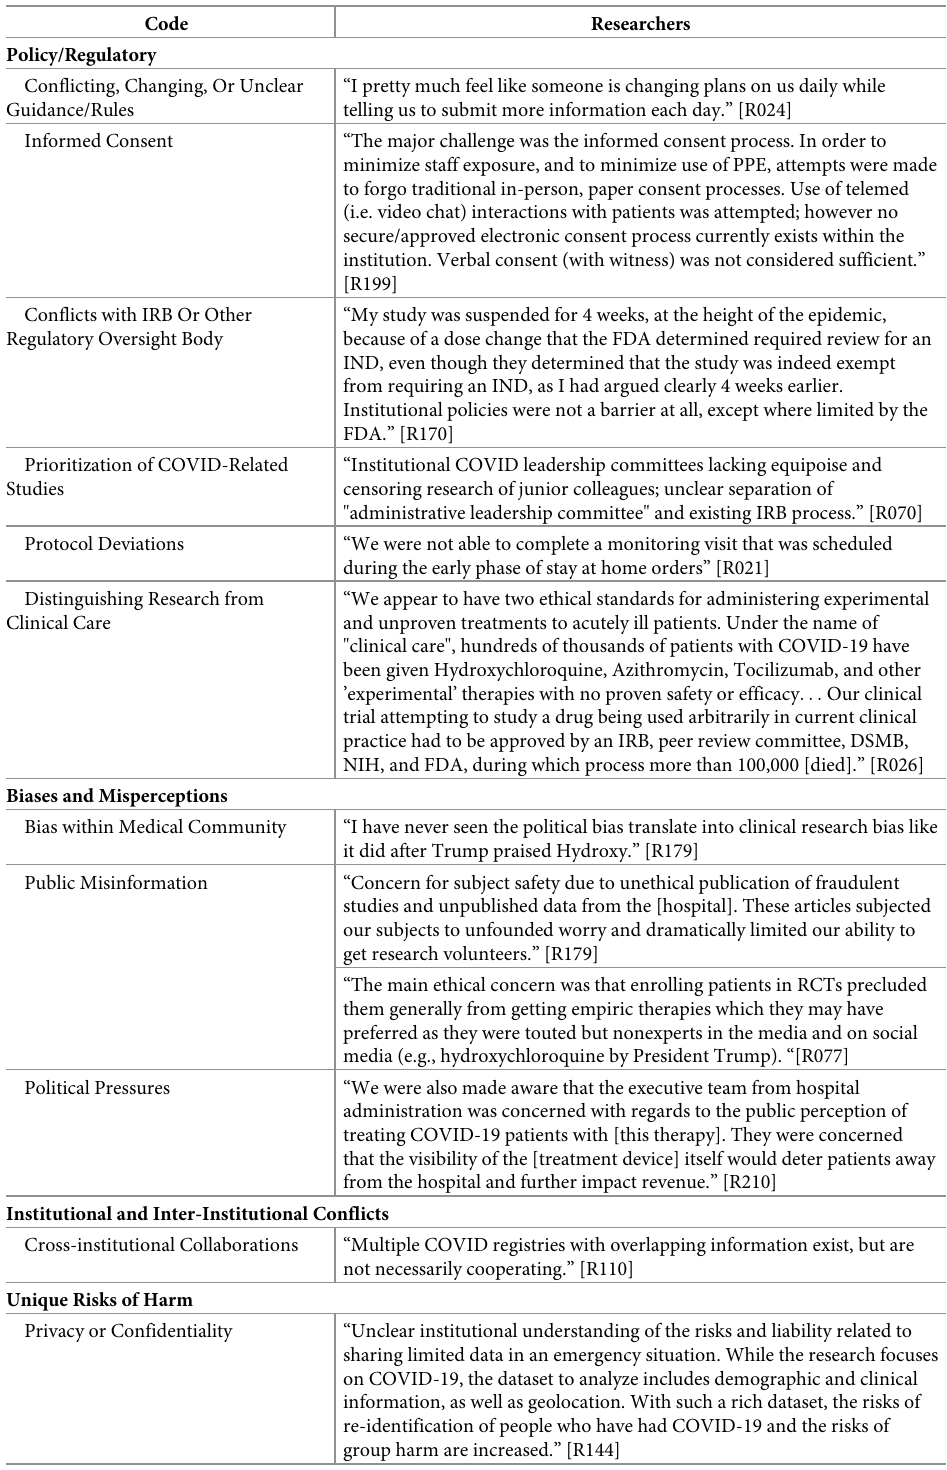
Table 3. Barriers to research—Researcher